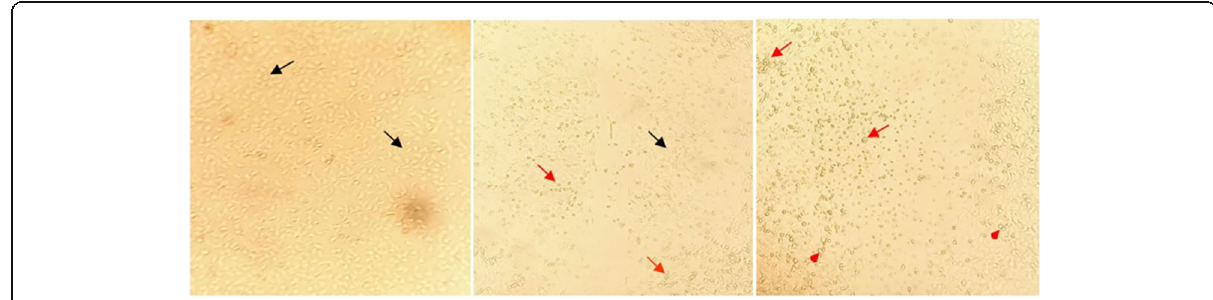
Fig. 4 Morphological changes of SCC-25 cells treated with artichoke extract for b 24 h and c 48 h viewed under an inverted light microscope. Control SCC-25 ( a ) was also included (× 200 magnification). Black arrows showed normal viable cells while red arrows showed cell shrinkage and nuclear condensation due to apoptosis. Red arrowheads showed the presence of apoptotic